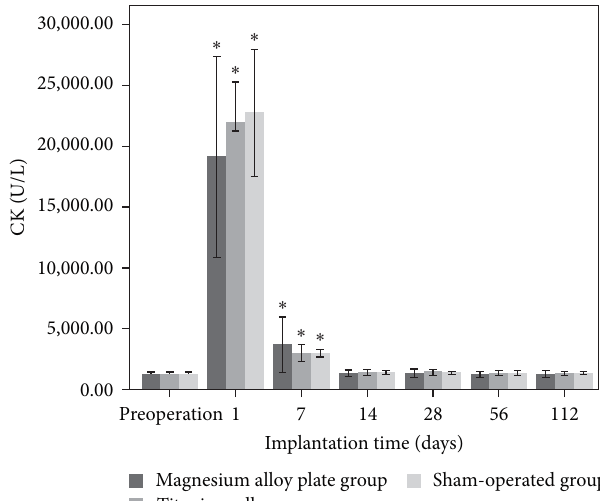
F IGURE 5: Results of CK levels before and after surgery in each group ( ∗ P < 0 : 05).